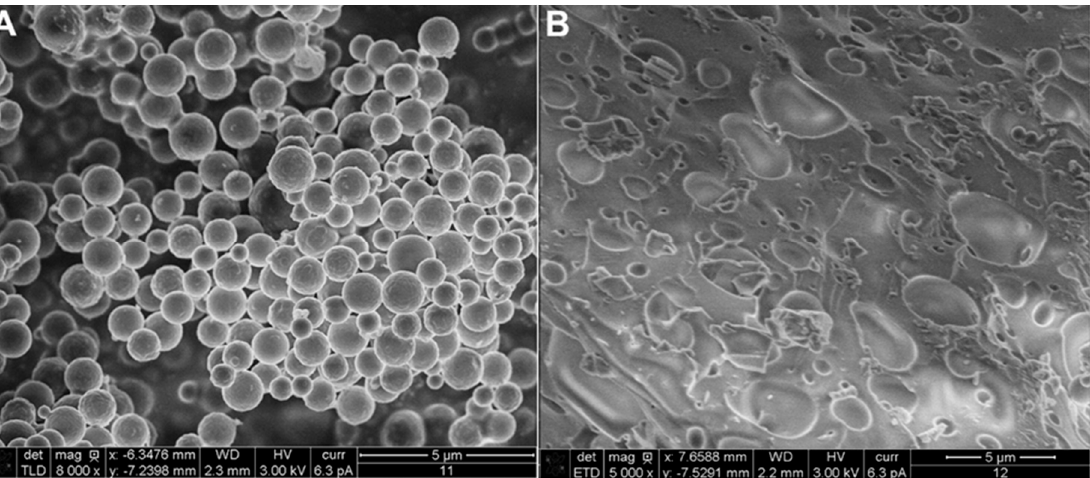
Figure 3. The morphology of LNPs collected by ( A ) freeze-drying and ( B ) centrifugation (Reprinted with permission from ref [29]. Copyright © 2020 Elsevier) .